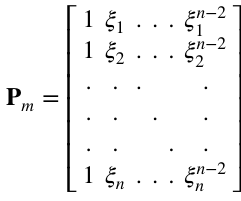
Fig. 7 Computational domain and boundary conditions for the second